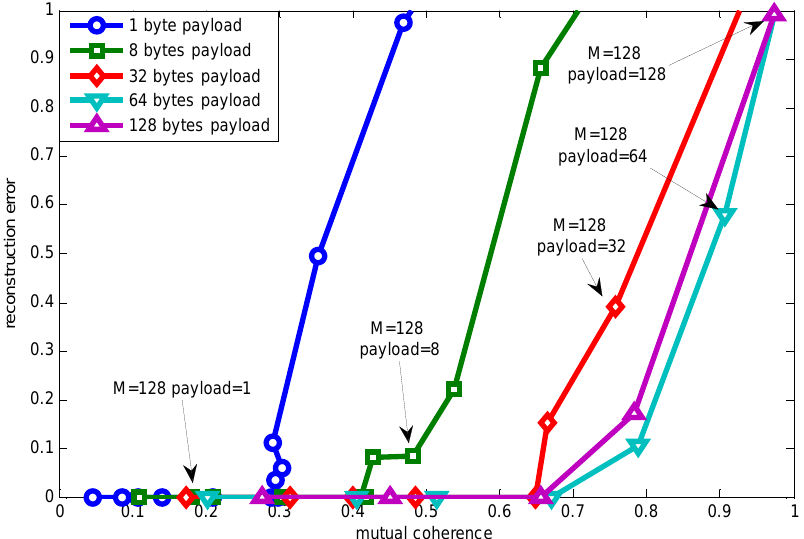
Figure 7. Relationship between mutual coherence and reconstruction error using RCS projection with K =